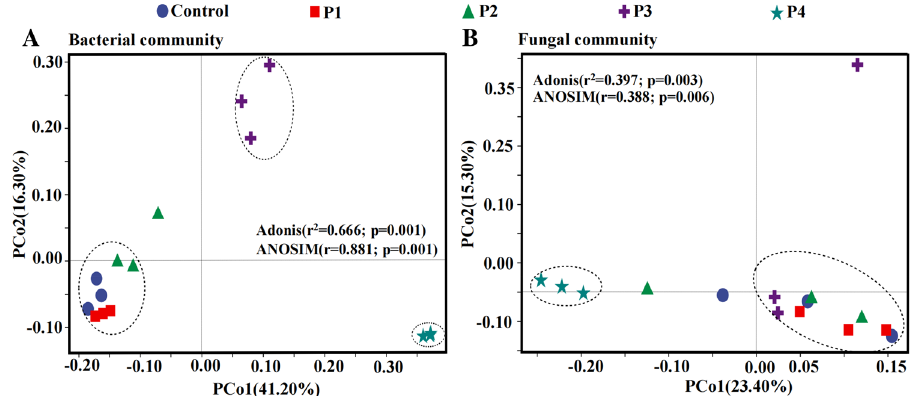
Figure 5. PCoA analysis of soil bacteria ( A ) and fungi ( B ) under different application rates of